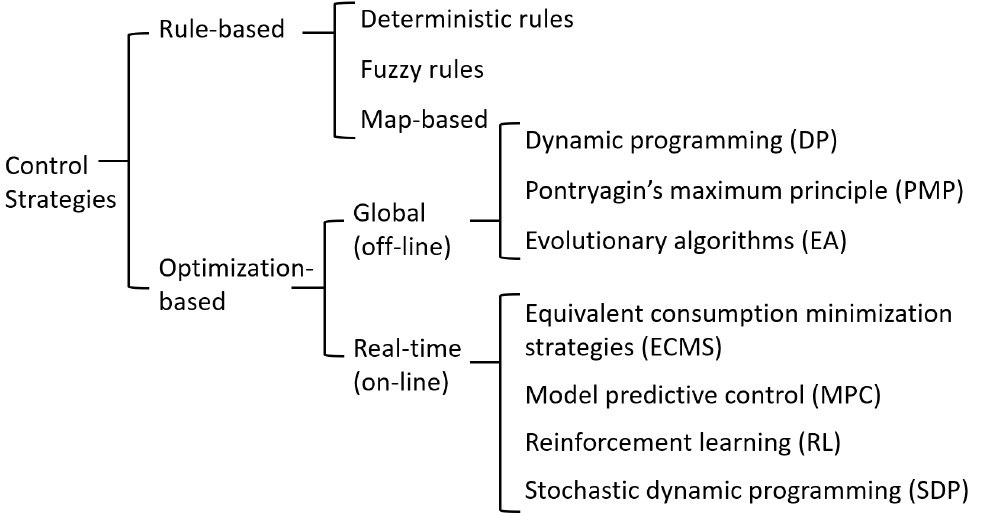
Figure 1. A selection of control techniques and how they fit into the overall landscape of